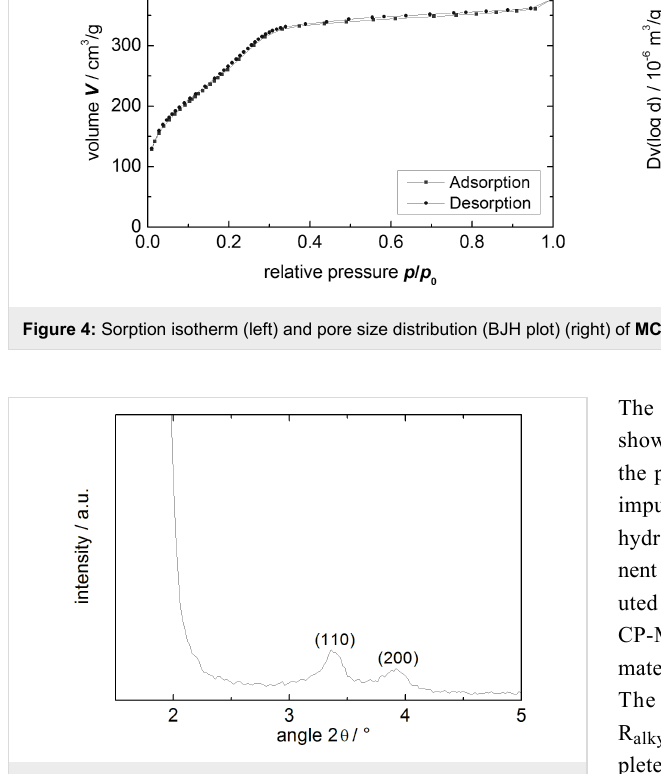
Figure 5: XRD pattern of MCM-ACR